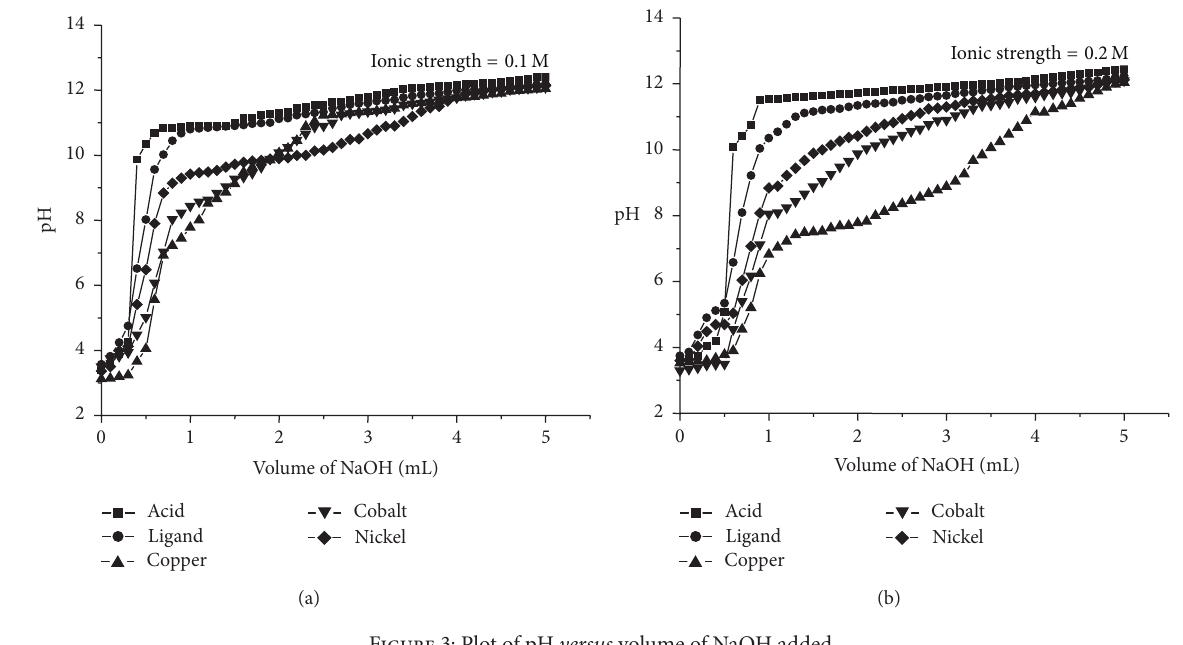
Figure 3: Plot of pH versus volume of NaOH